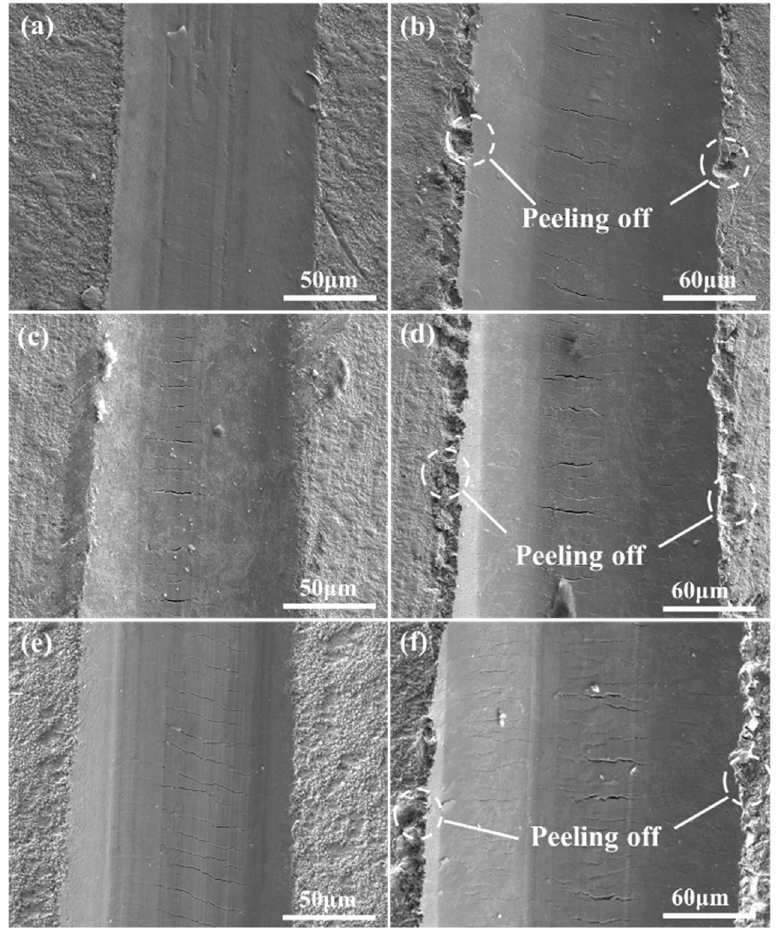
Figure 8. Scratch morphologies under different loads. ( a ) 1#, 70 N, ( b ) 1#, 109 N, ( c ) 2#, 70 N, ( d ) 2#, 107 N, ( e ) 3#, 70 N, ( f ) 3#, 150 N.